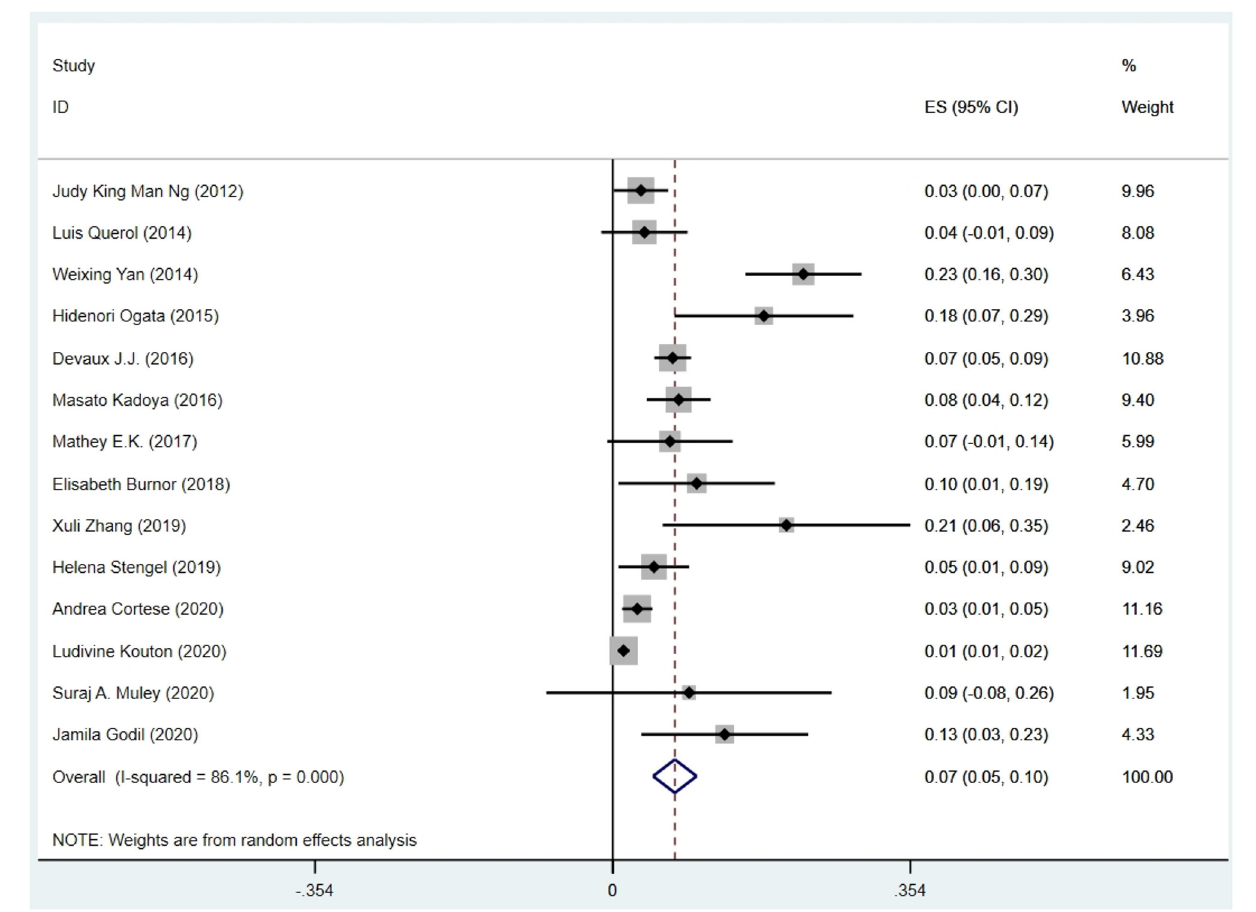
FIGURE 3 | The forest plot of the frequency of anti-NF155 autoantibody across 14 studies.